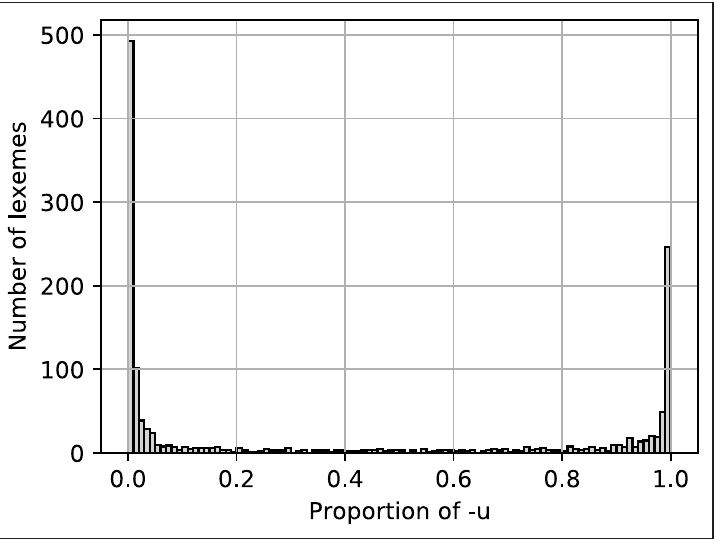
Figure 1 Histogram of the by-lexeme proportion of use of - u in the locative singular for overabundant hard masculine inanimate nouns with a token frequency of 100 or more, in the SYN corpus. Proportions of exactly 0 and exacly 1 are excluded; the first bar (resp. the last bar) hence shows the number of lexemes with strictly more than 0% and at most 1% (resp. at least 99% and strictly less than